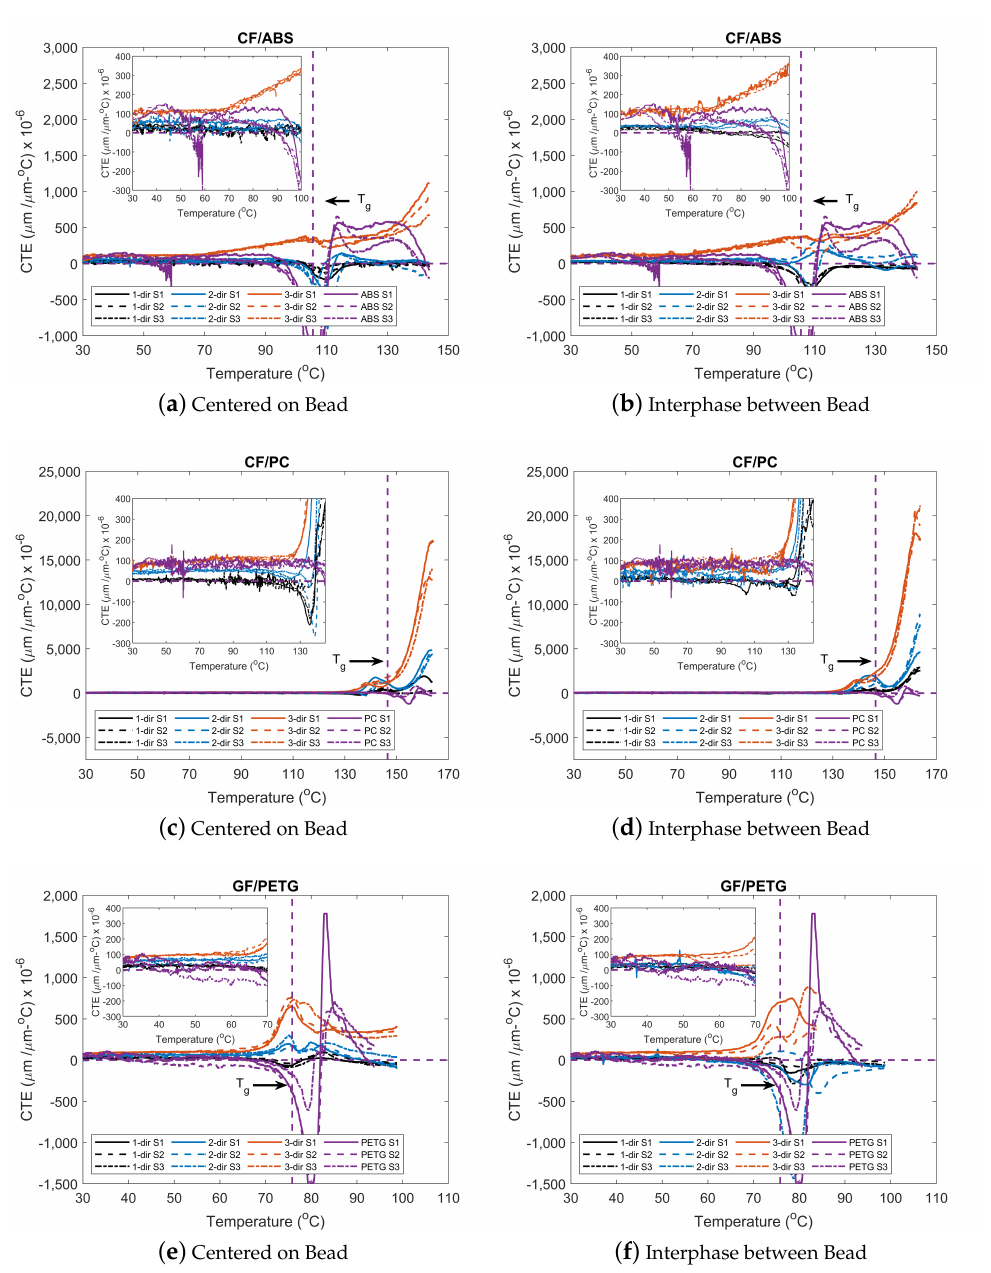
Figure 10. Coefficient of thermal expansion for ( a ) CF/ABS COB; ( b ) CF/ABS IBB; ( c ) CF/PC COB; ( d ) CF/PC IBB; ( e ) GF/PETG COB; and ( f ) GF/PETG IBB. S1, S2, and S3 correspond to sample 1, sample 2, and sample 3